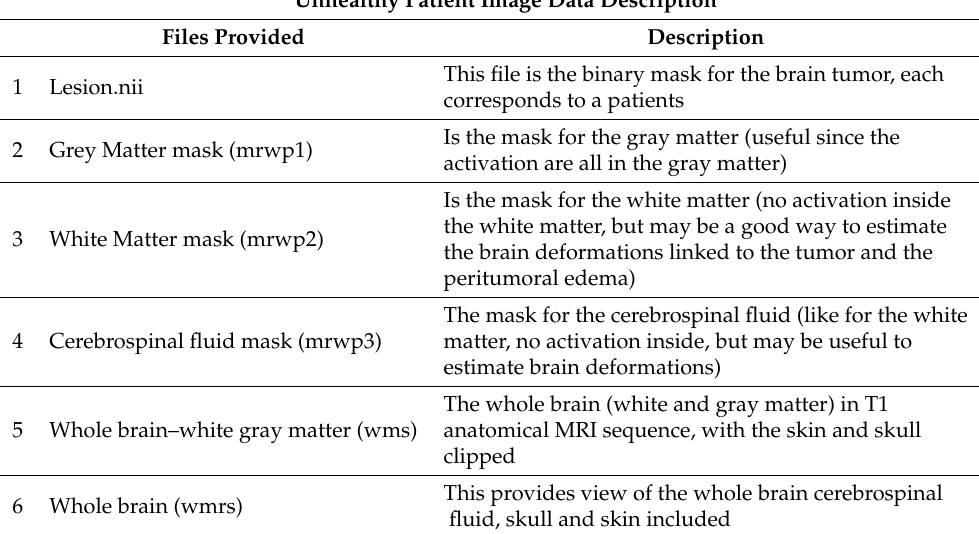
Table 1. Unhealthy patient data